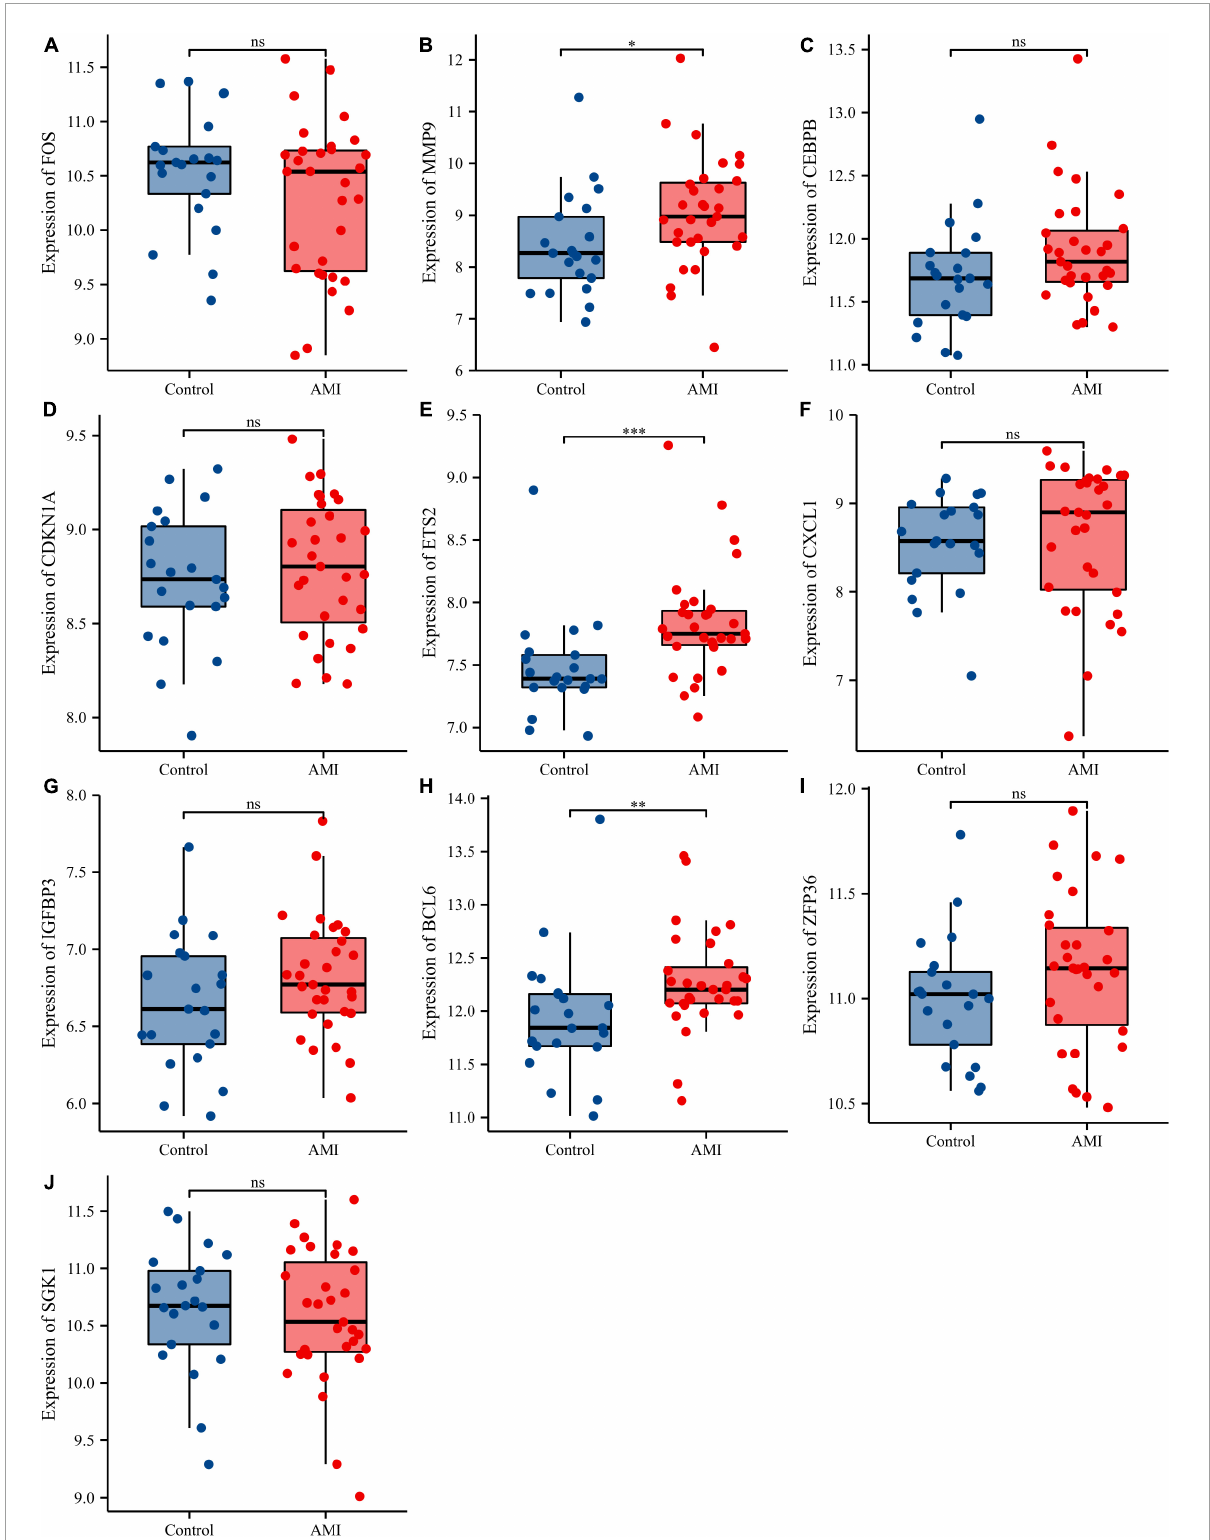
FIGURE11 Comparison of the expressions of 10 hub genes in the GSE48060 dataset. Expression levels of FOS (A) , MMP9 (B) , CEBPB (C) , CDKN1A (D) , ETS2 (E) , CXCL1 (F) , IGFBP3 (G) , BCL6 (H) , ZFP36 (I) , and SGK1 (J) . ns, no significance; ∗ p < 0.05; ∗∗ p < 0.01; ∗∗∗ p <